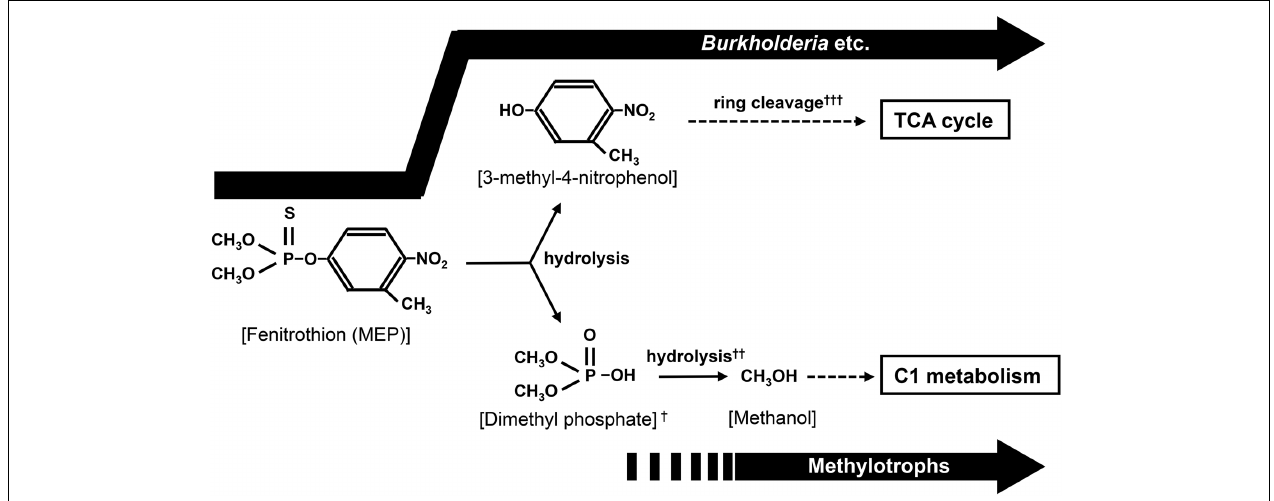
FIGURE 7 | Proposed biodegradation pathway of MEP. In addition to the utilization of 3-methyl-4-nitrophenole by Burkholderia and other bacteria, methanol generated from hydrolysis of dimethyl phosphate might be used as a carbon source by soil bacteria like methylotrophs. † P = S was rapidly